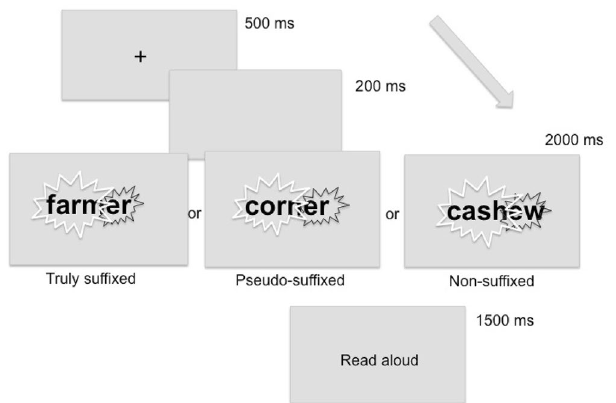
Figure 4. Delayed naming task procedure. The first part of the word, matching the embedded word (e.g., farm, corn, cash ), flickered on and off at 18.75 Hz. The remaining part of the word (e.g., er, er, ew ) flickered on and off at 12.50 Hz. The figure was created using Microsoft PowerPoint (https:// www. micro soft. com/).